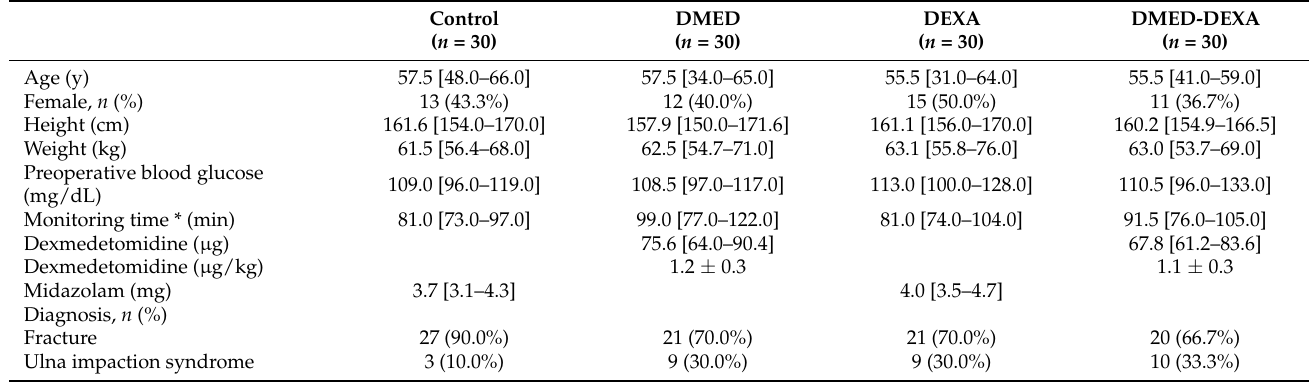
Figure 2. CONSORT flow diagram. * Data loss regarding the primary outcome (patient-controlled analgesia data). Table 1. Demographic and clinical characteristics of the study groups. Results are reported as median [interquartile range (IQR)] or as number (%). * Duration of standard ASA monitoring during stay in the operating